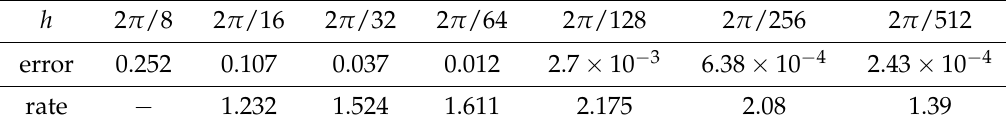
Table 1. Computational error in u h of (21) for α = 0.75 with respect to the L 2 ( Ω ) -norm with the experimental convergence